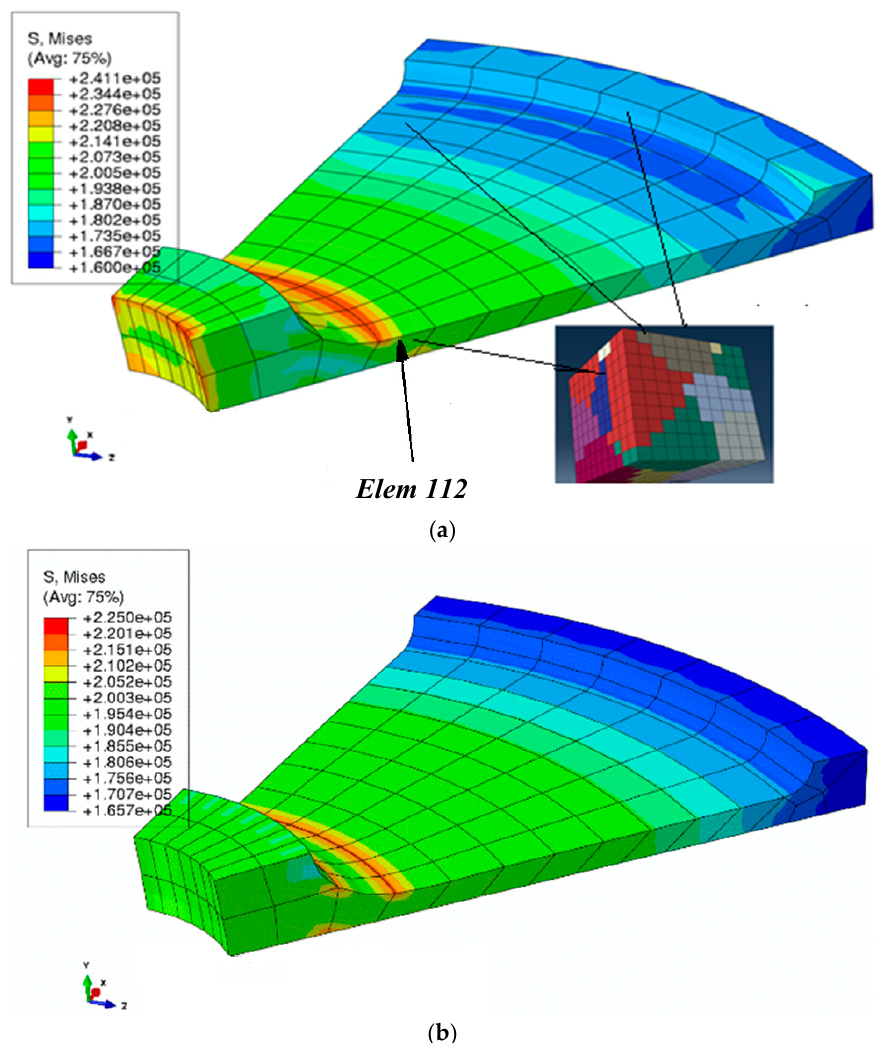
Figure 12. Von Mises stress distribution (× 10 (cid:2879)(cid:2871) MPa) in the real-size disk example: ( a ) linking macroscale to microscale using FEA/GMC; ( b ) applying the standard FEA model with a macroscale constitutive relationship.